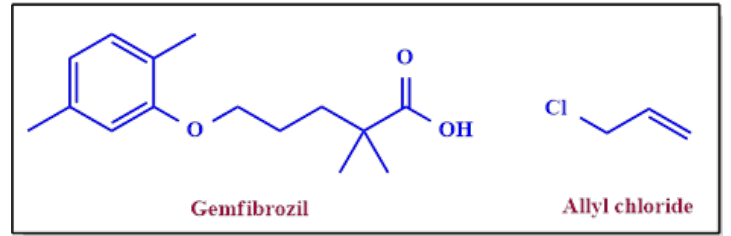
Figure 1. Structure of Gemfibrozil and Allyl chloride.